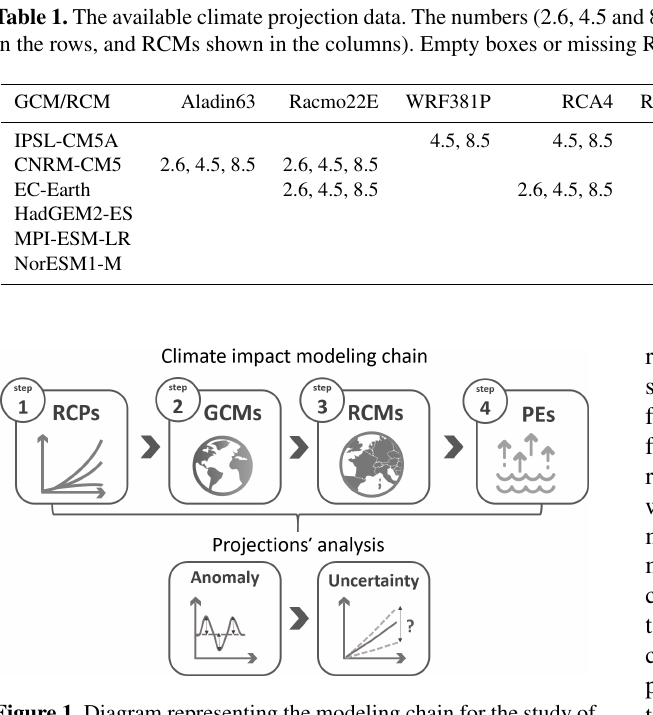
Figure 1. Diagram representing the modeling chain for the study of the impact of climate change on potential